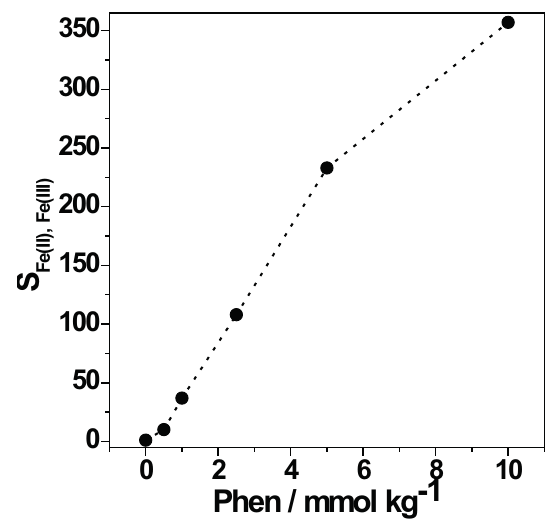
Figure 5 - Separation factor between Fe(II) and Fe(III) (S Fe(II),Fe(III) ) as a function of the quantity of 1,10-phenatroline (phen) added in the PEO1500 + Na 3 C 6 H 5 O 7 +H 2 O ATPS at pH=6.00; T=25.0 °C;